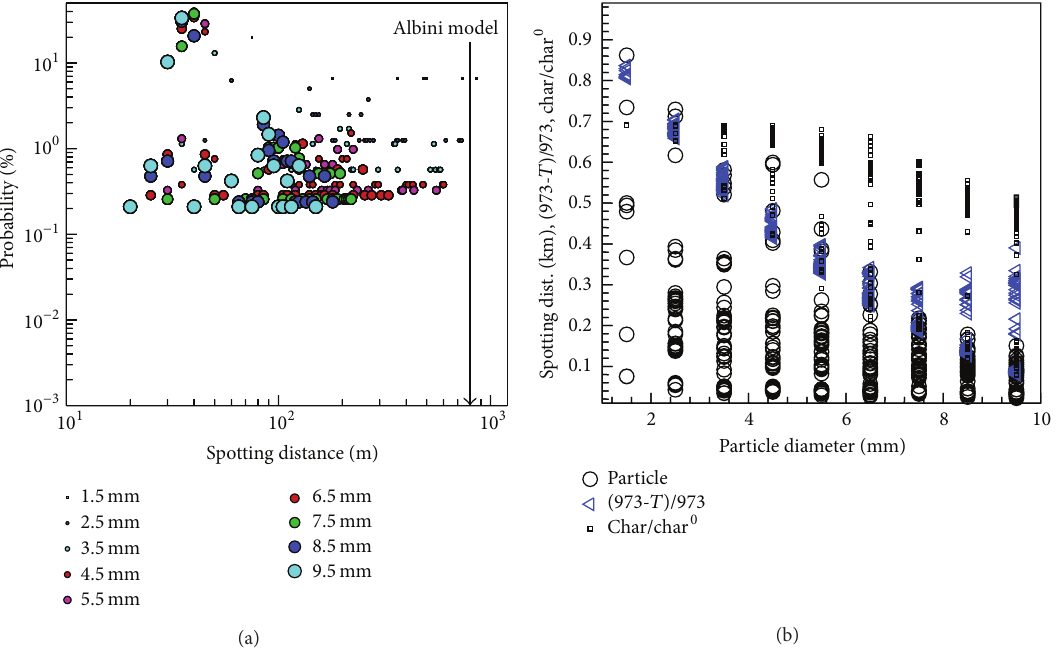
Figure 9: Four torching trees: (a) particle spotting distance; (b) char, temperature, and spotting distance as a function of particle size.